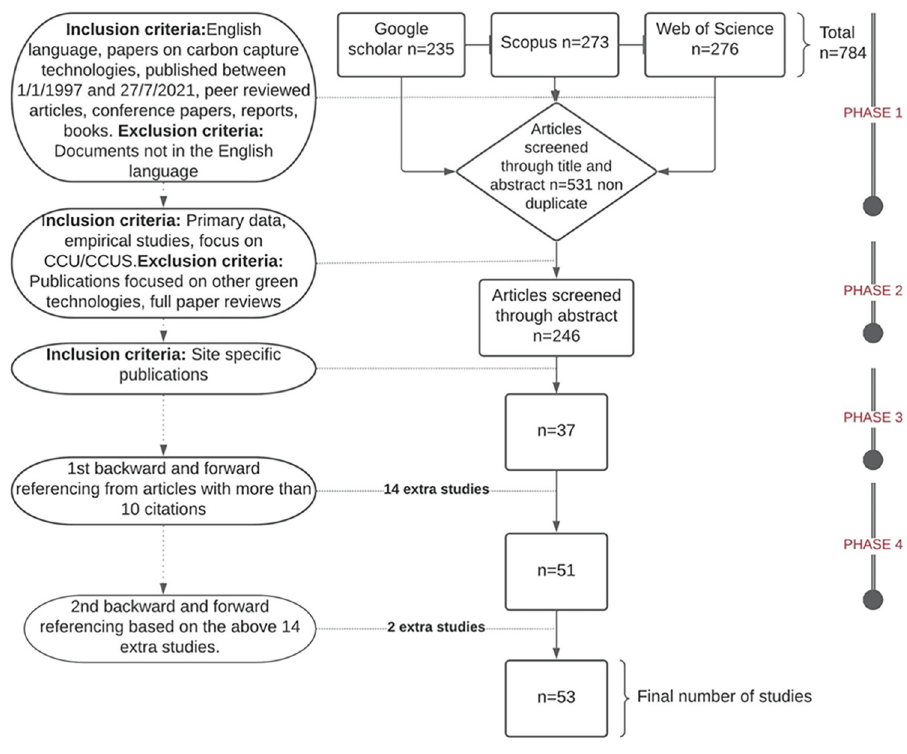
Fig 1. Identification of